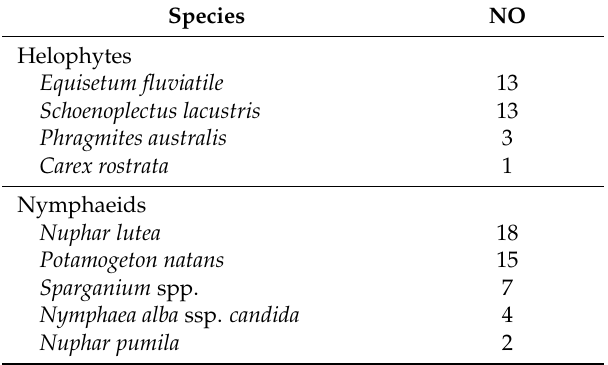
Table 1. Species inventory list of non-submerged vegetation at Lake Ostträsket with number of observations (NO) within 25 circle plots, radius 10